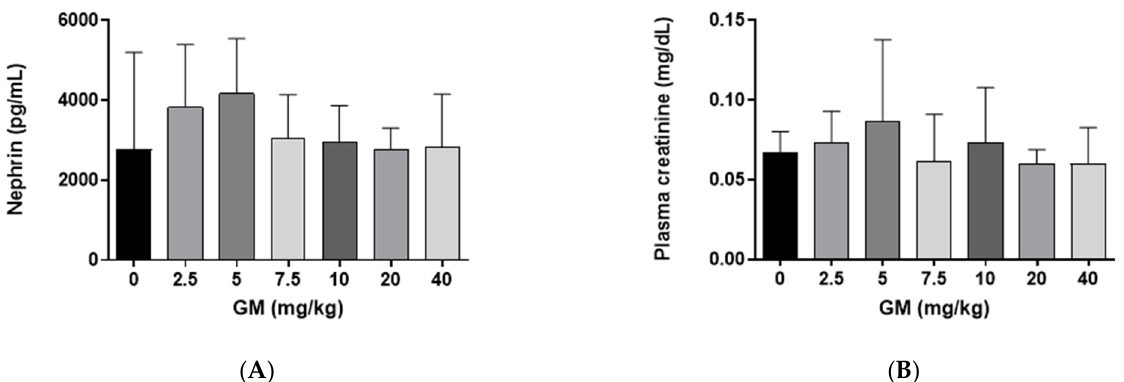
Figure 1. Subacute administration of GM does not modify the glomerular filtration barrier of C57BL/6J mice ( A ) Quantifi- cation of nephrin in whole renal tissue. One-way ANOVA, Kruskal Wallis, p = 0.7489; ( B ) Plasma creatinine levels. One- way ANOVA, Kruskal Wallis, p = 0.6638. Bar graphs show means ± SD, n = 5 animals per dose.